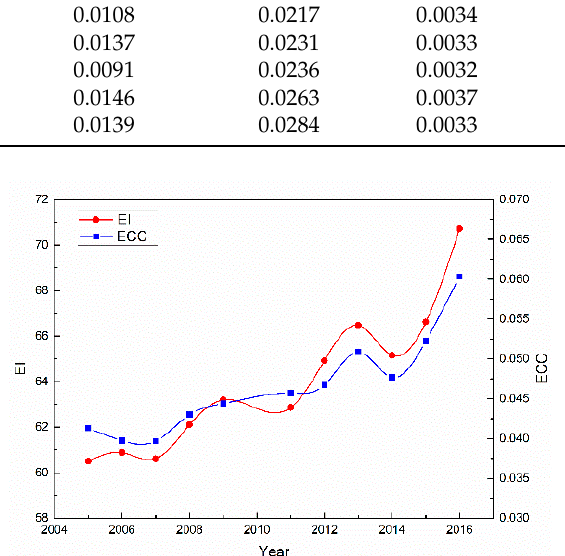
Figure 8. The trend of the EI and ecological carrying capacity over 2005 to 2016.